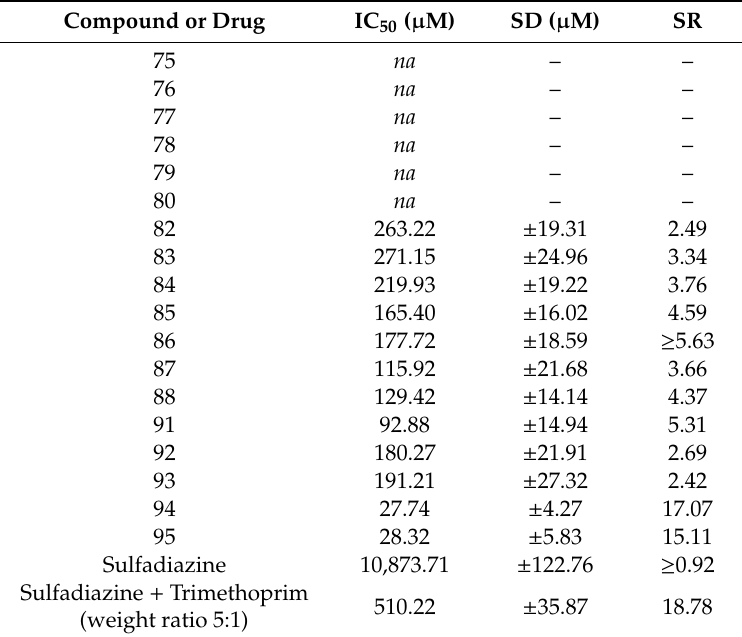
Table 2. Anti- T. gondii tachyzoites activity of (4-oxothiazolidin-5-yl)acetic acid ( 75 – 80 and 82 – 88 ), (4-oxothiazolidin-5-ylidene)acetic acid ( 91 – 95 ) and drugs; na —not active against T. gondii in the tested concentration range; SD—standard deviation; SR—selectivity